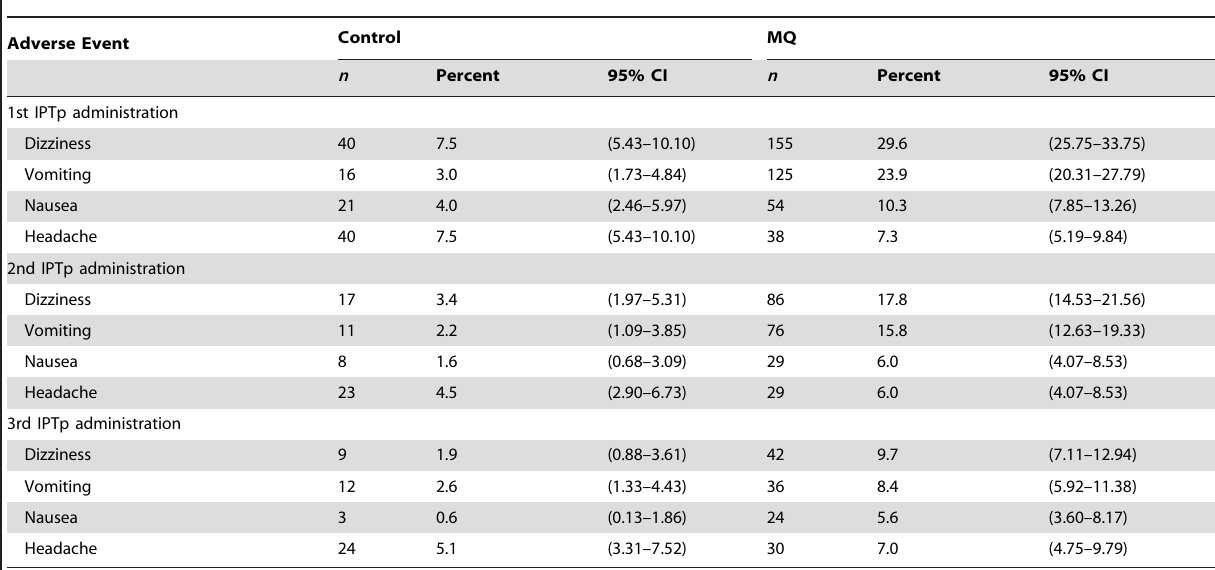
Table 8. Most frequent medication related adverse events (safety